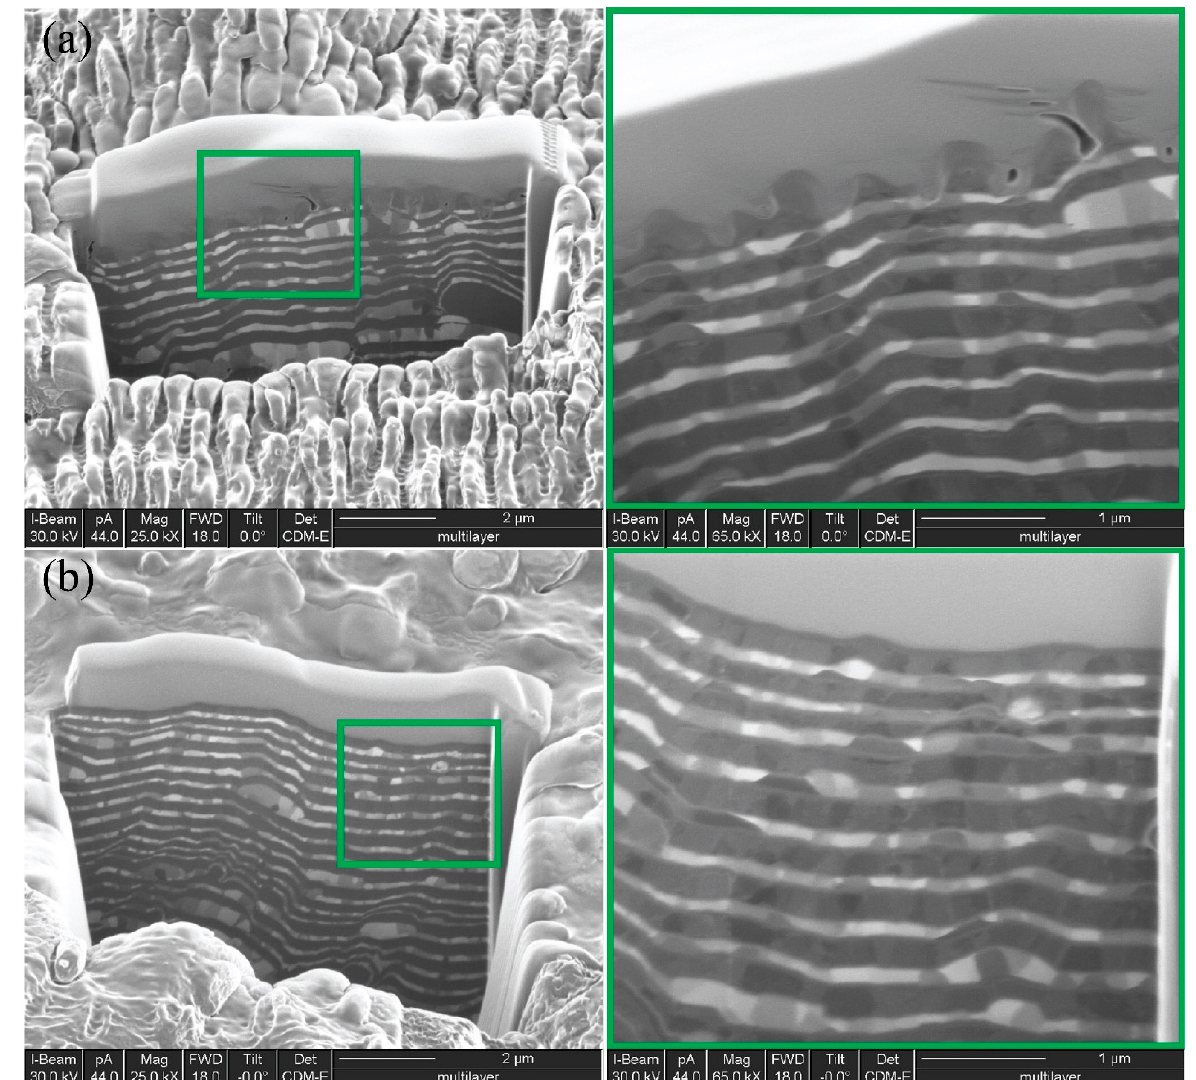
Figure 3. SEM micrographs of the vacuum-arc condensed Ti-Fe multilayer with layer formation ( b ) and after LIPSS formation ( a ) made by shot by gallium ion beam.